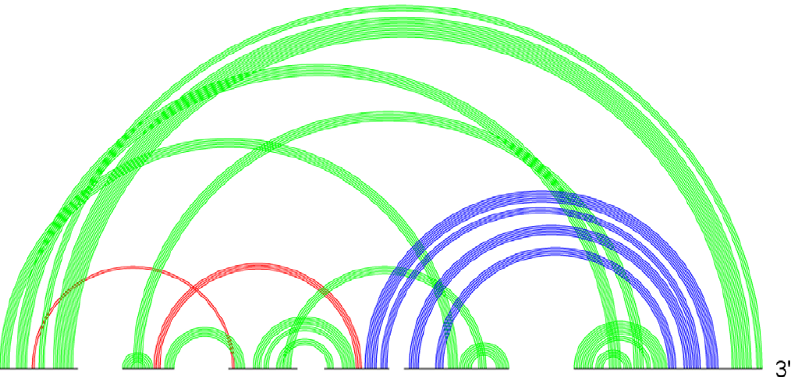
Figure 7. Typical sample structures for all genus 5 subclasses . RNA sequence CRW_00575 of subclass 5A with pseudoknot pattern ABCDEFEGHCHIJIGKALJLMNBNFMKD. (Stem color, blue: major stem; green: intermediate stem; red: minor